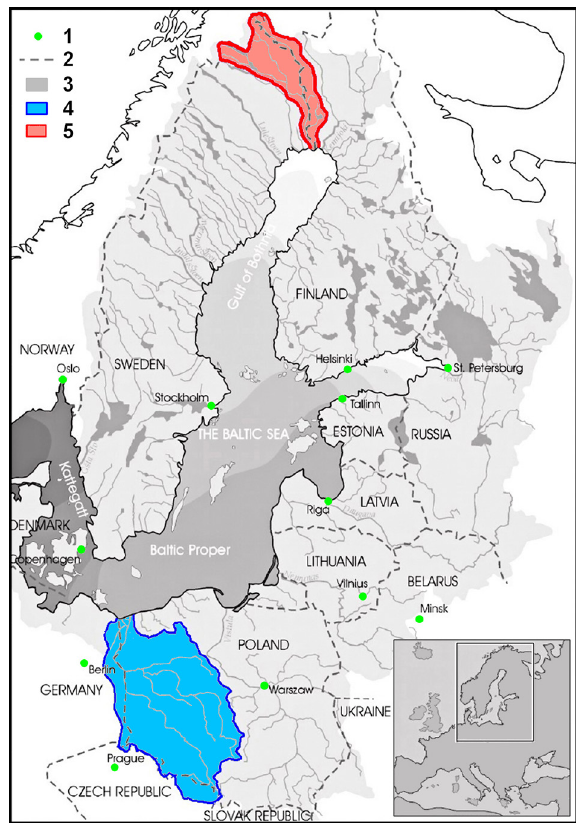
Fig. 1. Location of case study river basin management areas in the Baltic Sea catchment